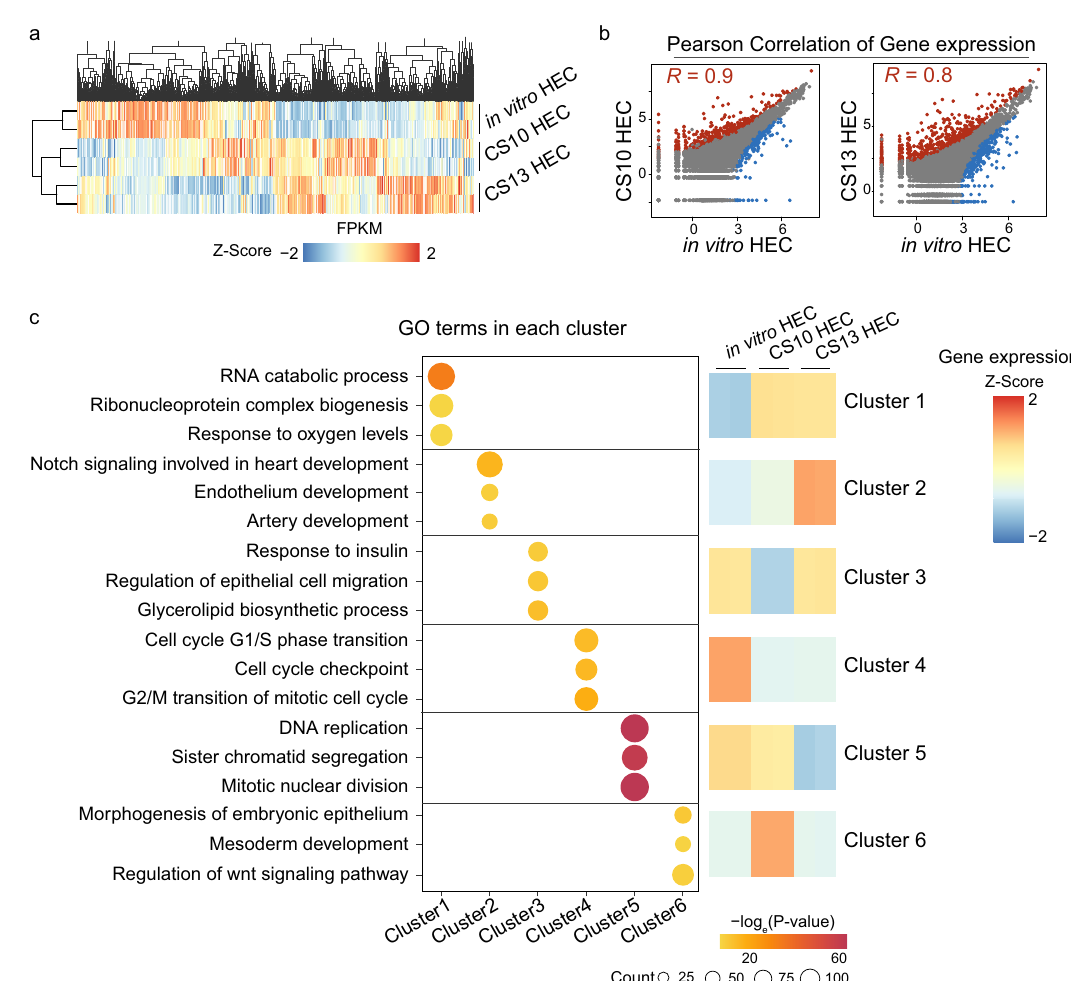
Fig. 5 Comparison of single-cell transcriptome between in vitro HEC and in vivo HEC. a Heatmap showing the gene expression patterns in CS10 HEC, CS13 HEC and in vitro HEC. The color gradient represents gene expression value. b Scatterplots showing the correlation between in vitro HEC, CS10 HEC, and CS13 HEC, respectively, with the coef fi cient of determination. The differentially expressed genes are highlighted. Blue, red, and gray dots represent the upregulated genes, downregulated genes, and stable genes in in vitro HEC respectively. c GO analysis of top differential upregulated genes in CS10 HEC, CS13 HEC, and in vitro HEC. The dot color shows the enrichment from Fisher ’ s exact p value. CS Carnegie stage, HEC hemogenic endothelial cell. Source data are provided as a Source Data fi